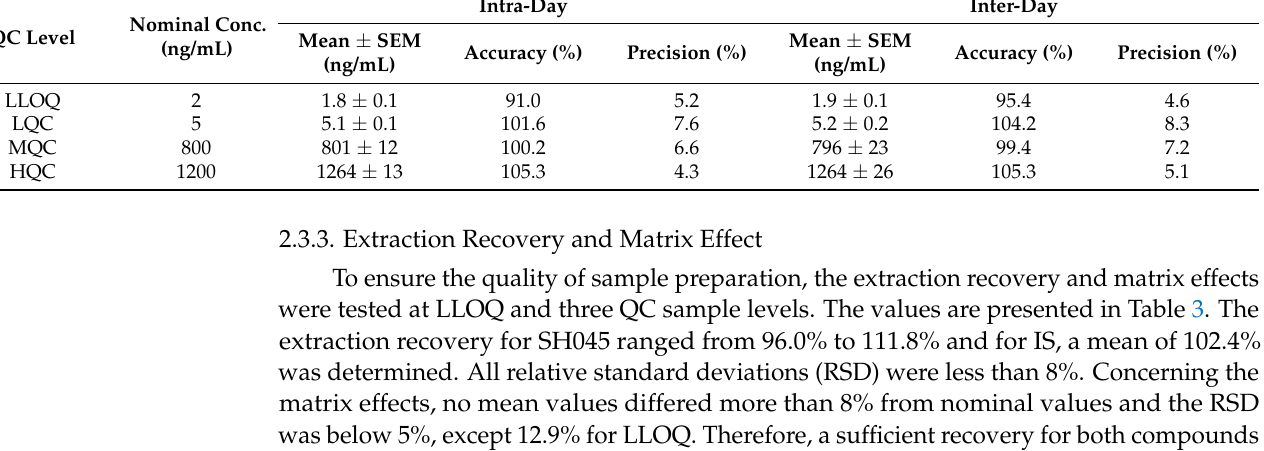
Table 2. Intra- and inter-day accuracy and precision for SH045 detection in mice plasma ( n = 6). Nominal Conc. QC Level